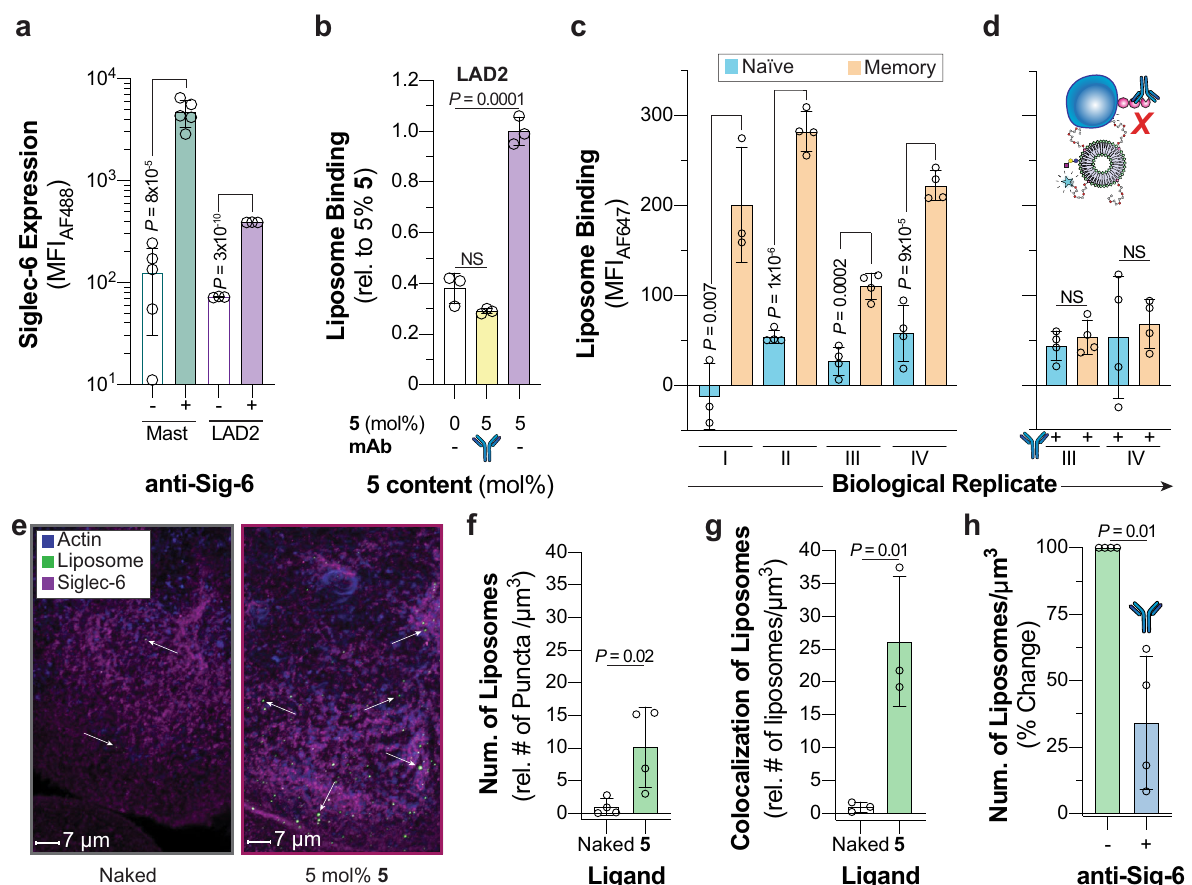
Fig. 5 | Targeting Siglec-6 on human cells and tissues. a Siglec-6 expression levelson primarymastcellsisolated from healthy humanspleendonorsand LAD2 cells.Fortheprimarymastcells,eachdatumrepresentsabiologicalreplicant( n =5 biological replicates). b Binding of 5 nGLLs to LAD2 after treatment with an anti- Siglec-6 antibody quanti fi ed by fl ow cytometry ( n =3 technical replicates). c and d 5 liposome binding to humannaïve and memoryB-cellsisolatedfrom the blood of four healthy biological replicants (represented with Roman numerals) without and with pretreatment of Siglec-6 blocking antibody, respectively (4 ≥ n ≥ 3 tech- nical replicates). e Representative confocal microscopy images of human syncy- tiotrophoblastsaftertreatmentwithnakedand 5 nGLLs.Quanti fi cationofthetotal